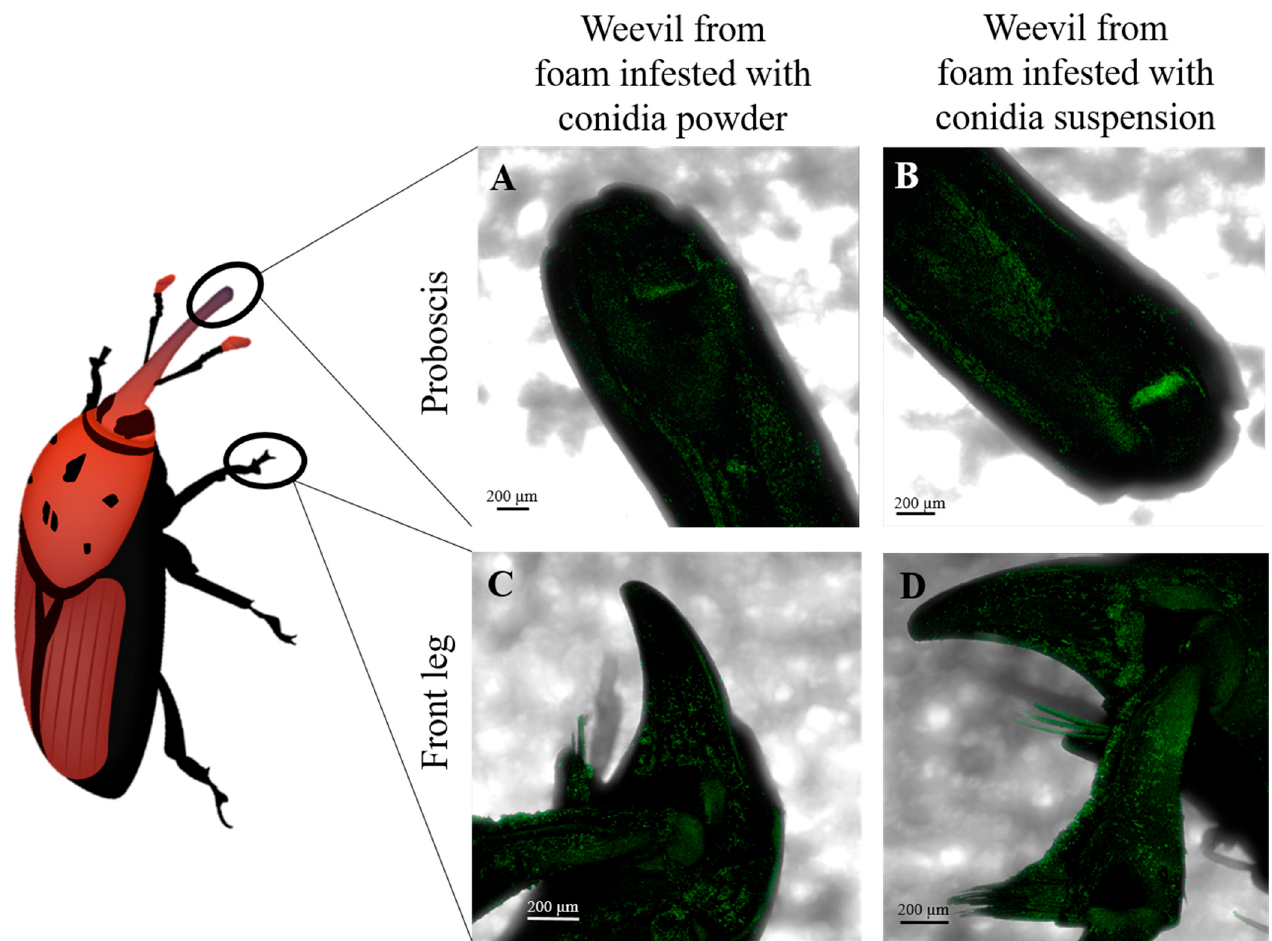
Figure 4. Confocal laser scanning micrographs of female weevil proboscis ( A , B ) and front leg ( C , D ) after exposure to foam treated with Mb7-GFP conidia powder, 5 × 10 8 conidia in total ( A , C ) or Mb7-GFP conidia suspension 10 8 conidia mL − 1 ( B , D ). Scale bar = 200 µm.